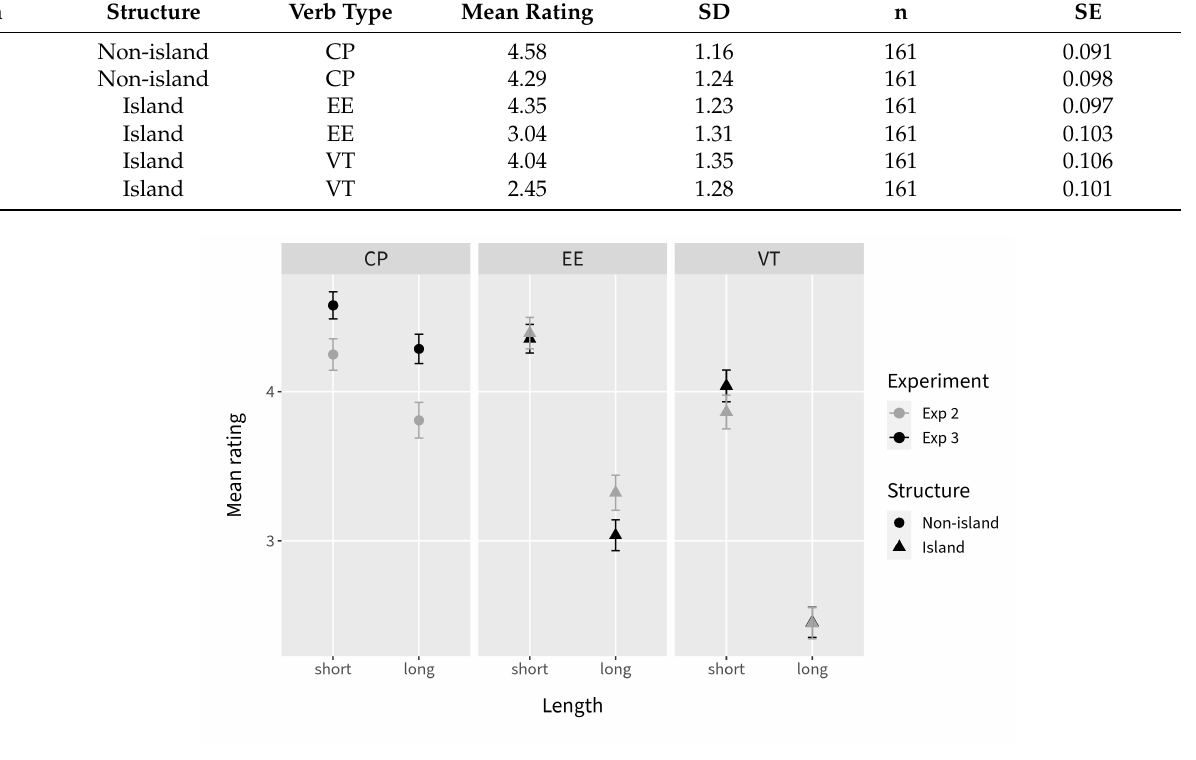
Figure 8. Mean ratings for Experiment 3 (Experiment 2 ratings shown in light gray). Error bars represent the standard error. Mean is calculated on raw (non-z-scored)